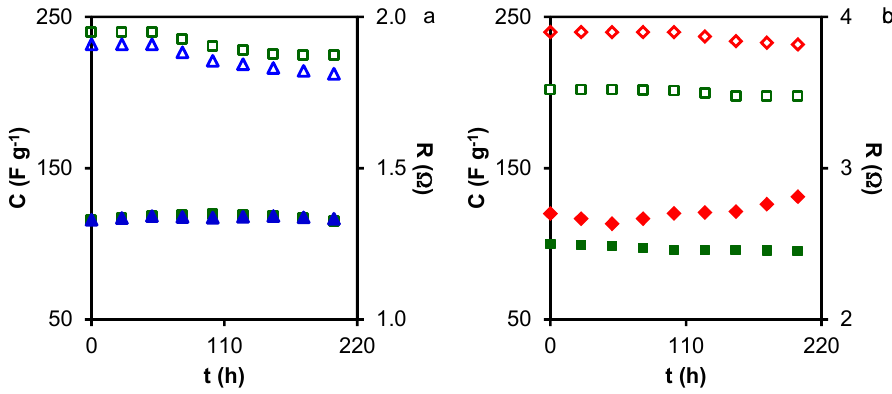
Figure 5. Floating tests of samples: ( a ) MA2 ( △ ), and MA3 ( □ ); ( b ) CMA4 ( ◇ ), and HCM200-2 ( □ ). Gravimetric capacitance (open symbols) and resistance (closed symbols).